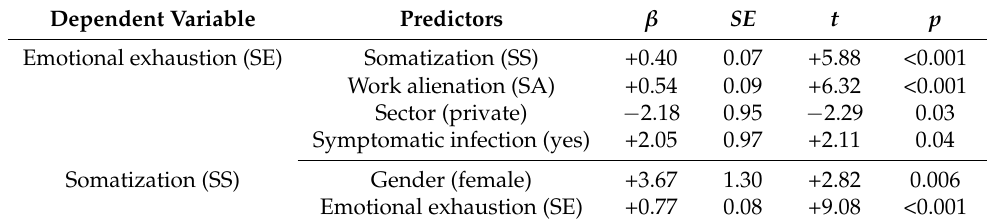
Table 3. Multiple linear regression models for somatization and emotional exhaustion measures.